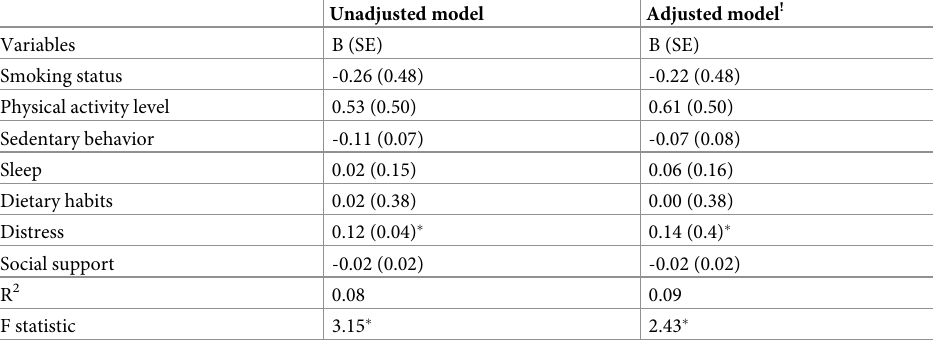
Table 5. The relationship between fear of COVID-19 (n = 276) and lifestyle behaviors (smoking status, PA, SB, sleep, dietary habits, distress, and social